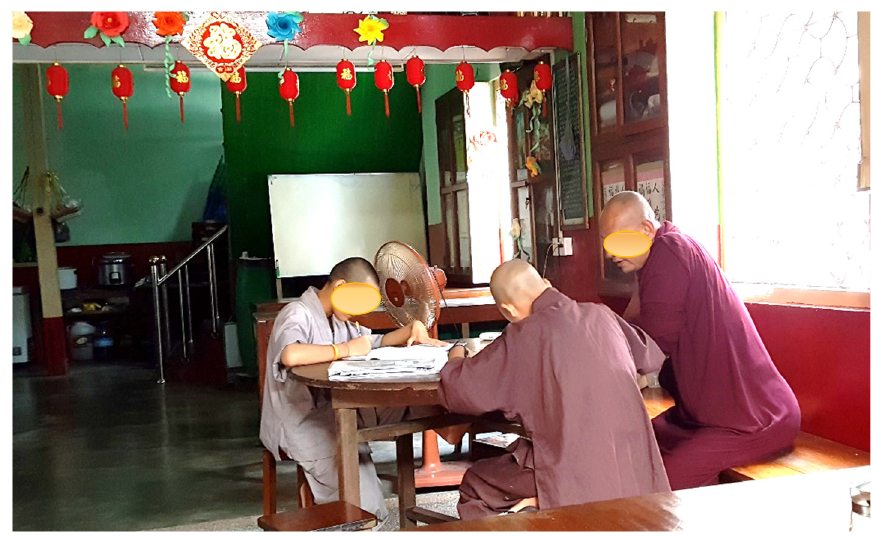
Figure 2. A Burmese monk teaching female novices at Zhonghua Si (Source: Author).